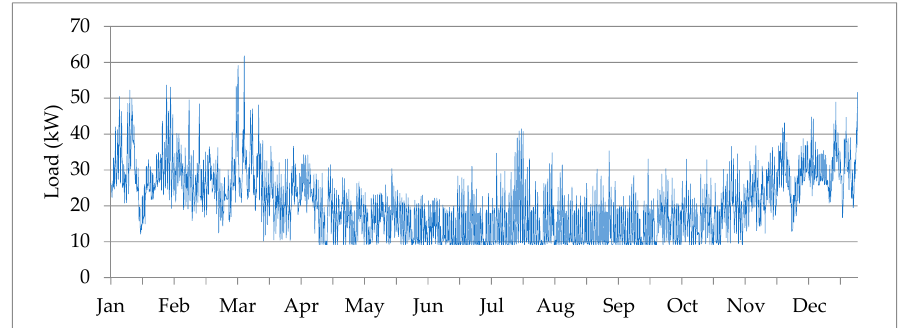
Figure 8. Combined electric load profile for DPW.